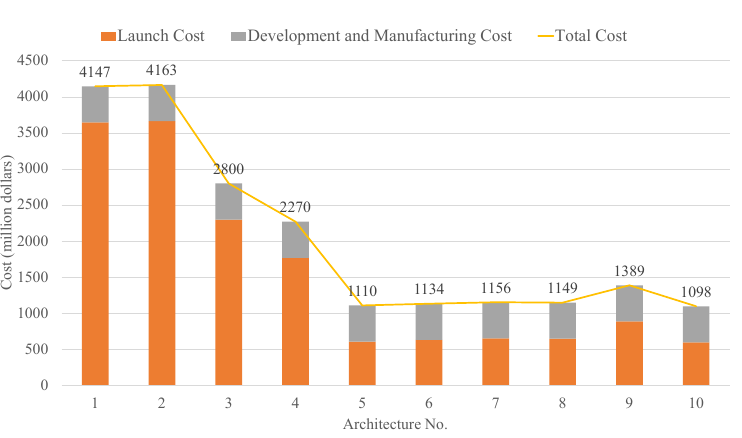
Figure 16. Total cost of 10 different